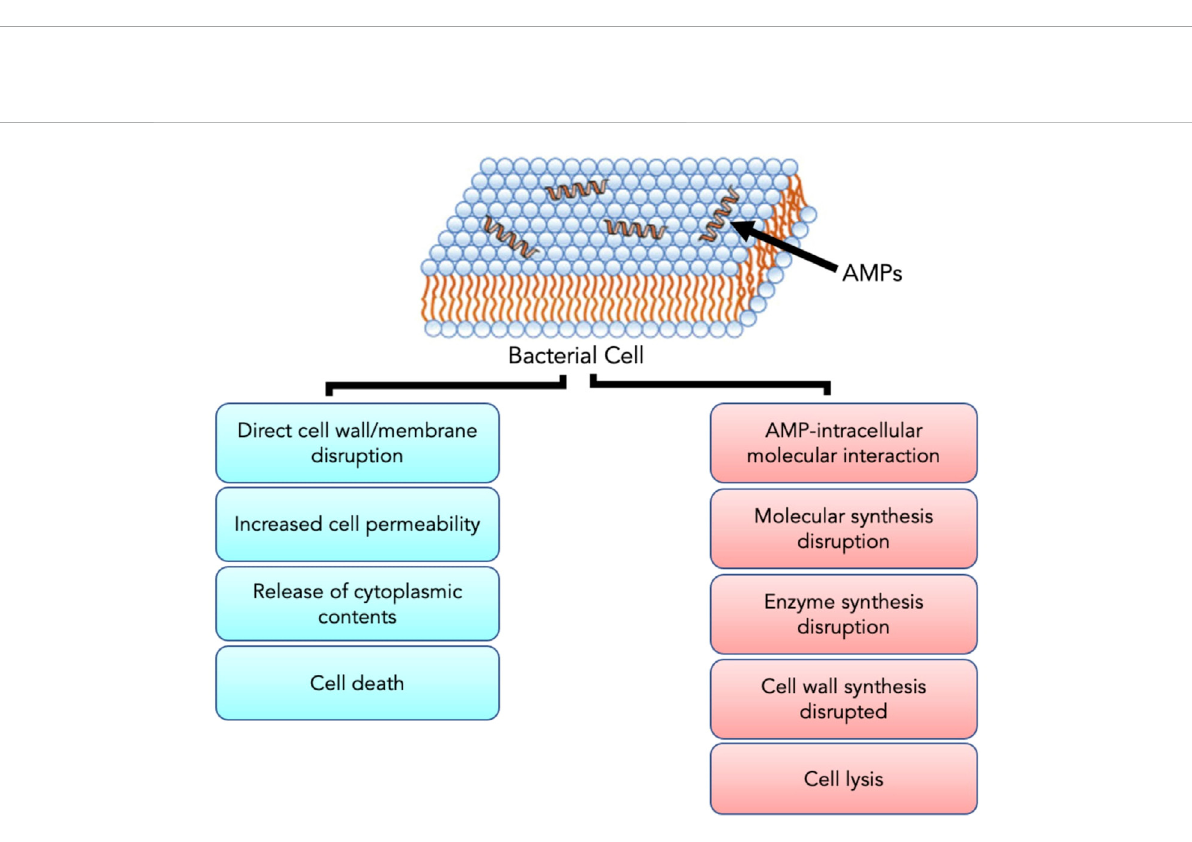
FIGURE 5 The positive charge of AMPs facilitates interaction with the negatively charged bacterial cell membrane. Upon interaction and subsequent penetration into the cell, AMPs either result in cell death through direct cell wall/membrane disruption or cell lysis by disrupting the synthesis of proteins and cell walls. Adapted from Zhang et al.